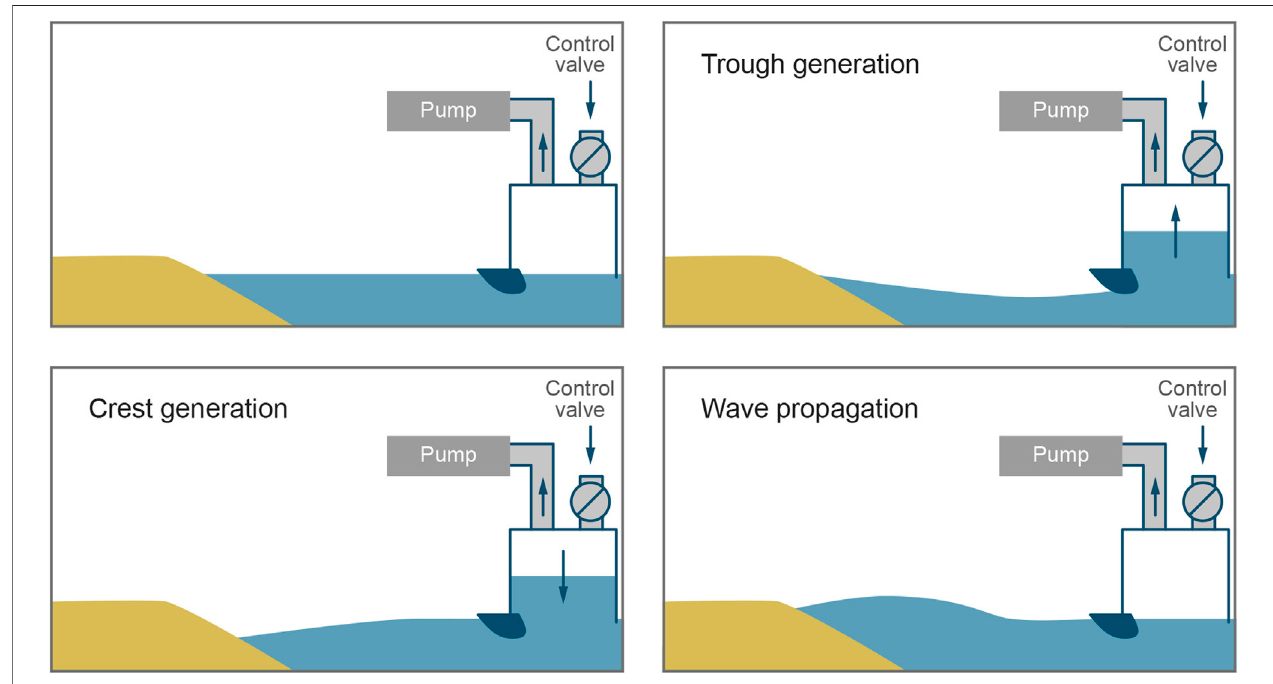
FIGURE 1 | Schematic diagram of pneumatic Tsunami Simulator wave generation. From top left to bottom right: pump on and control valve open; pump on and control valve closed creating wave trough; pump on and control valve open creating wave crest; wave propagating along fl ume.